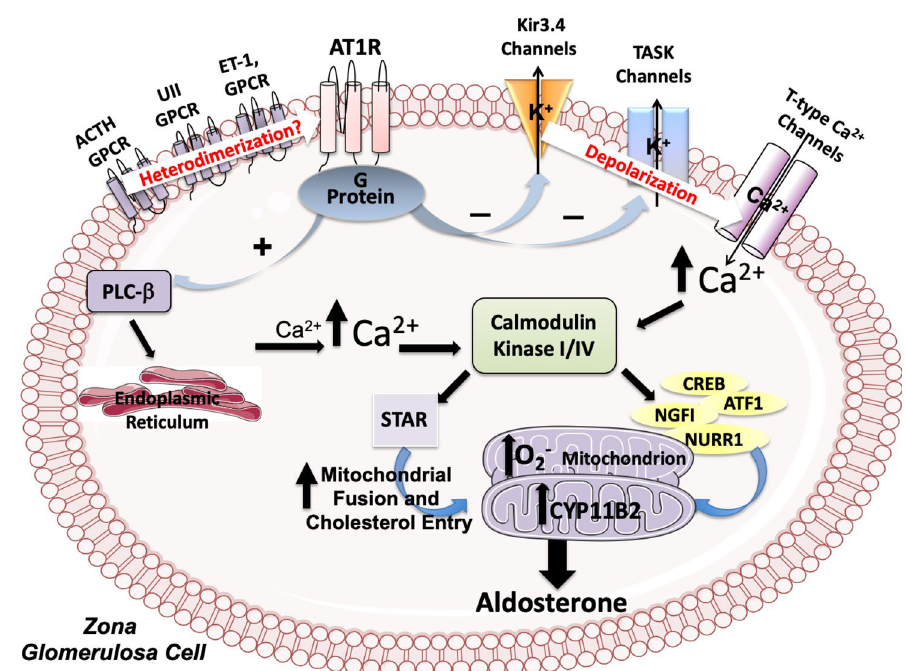
Figure 2. Molecular pathways modulated by Ang II in adrenal zona glomerulosa cells. Ang II, by acting through the AT1R stimulates the expression of the aldosterone synthase coding gene ( CYP11B2 ) by increasing intracellular Ca 2+ through the modulation of the activity of the PLC-β and of the GIRK4, and of the TASK channels. The increase of intracellular Ca 2+ activates the calmodulin kinase (CaMK) cascade which acts on CYP11B2 expression by phosphorylating the transcription factors Activating Transcription Factor 1 (ATF-1), cyclic adenosine monophosphate response element (CRE)-binding protein (CREB) and nuclear receptor related 1 (NURR1). Ang II also increases the aldosterone synthase activity by activating NAPDH oxidase and, thereby, by elevating reactive oxygen species (O 2- ) in the mitochondria and by promoting fusion of mitochondria and translocation in these organelles of relevant steroidogenic acute regulatory. Finally, heterodimerization of AT1R with other G protein-coupled receptors (GPCRs) is supposed to be involved in aldosterone